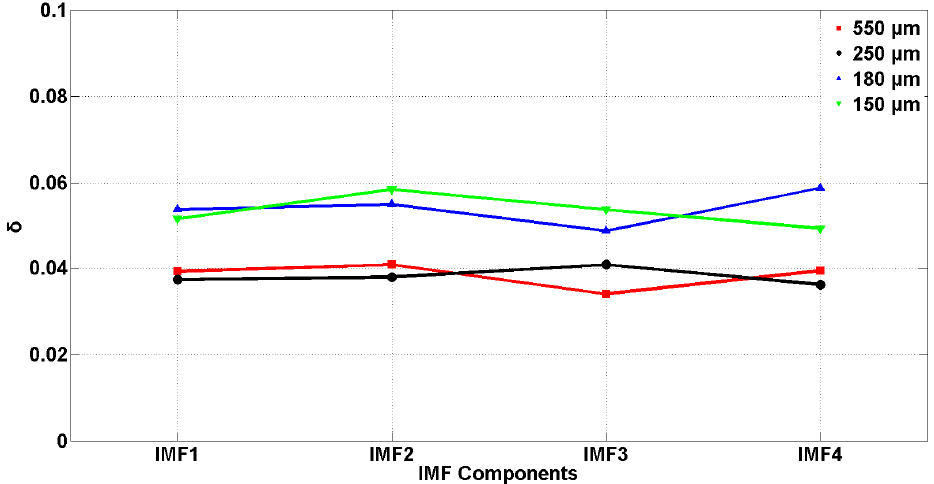
Figure 13. Average relative deviation from linearity for the IMF features given different particle sizes.